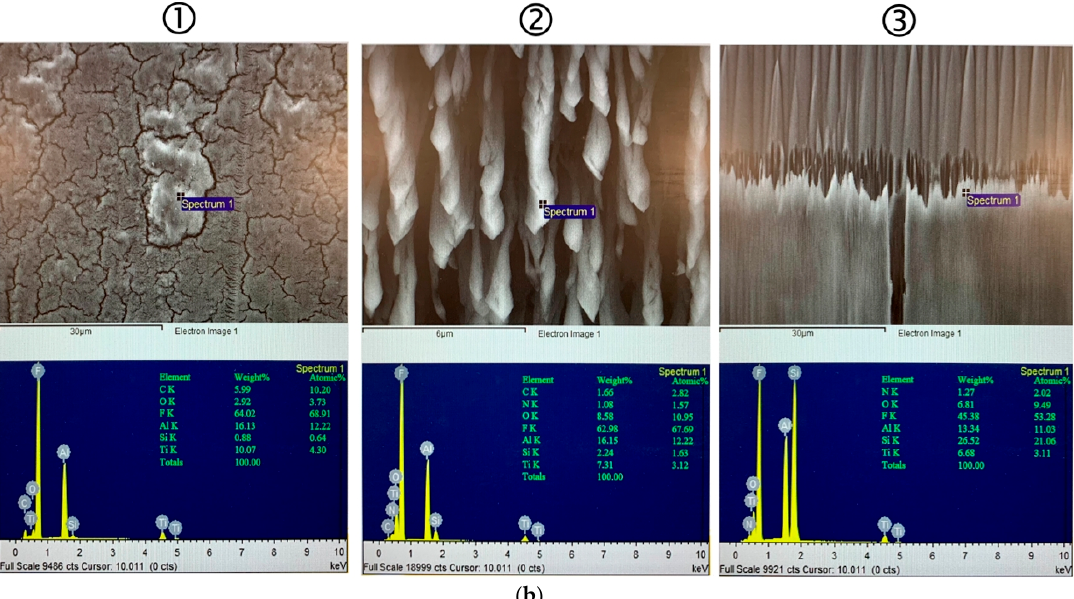
Figure 5. Chamber deposition position analysis for the ESC and edge ring. ( a ) By-product deposition positions around the (1) ESC side wall and related parts, (2) inner side of the edge ring, and (3) surface of the edge ring. ( b ) SEM images and EDX spectra for the deposited by-products. The most common elements in the deposited by-products were fluorine, aluminum, and oxygen. The composition of these by-products was similar to that of the edge particles.